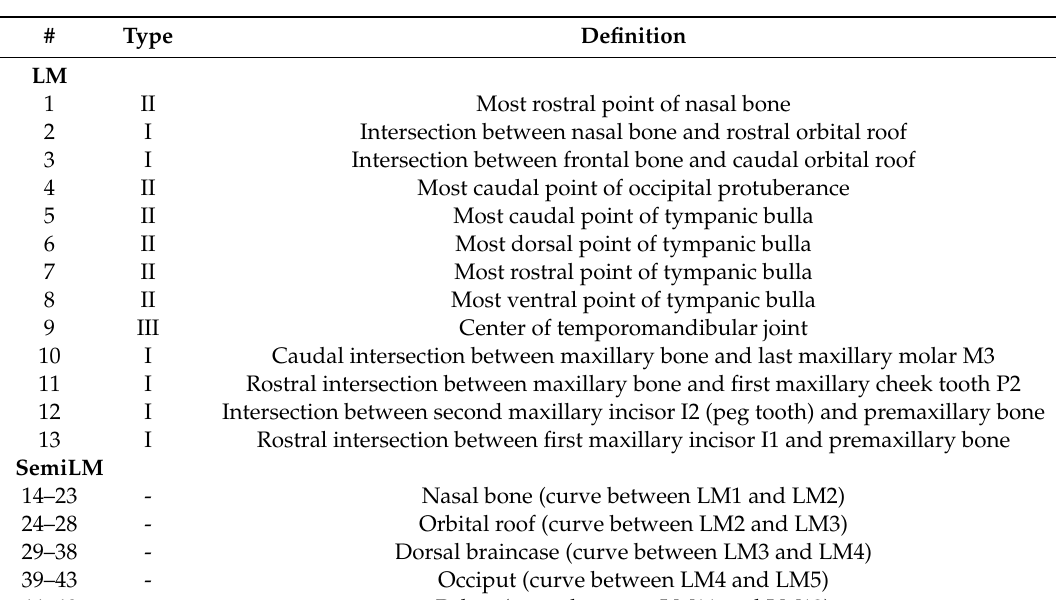
Table 2. Definition of the landmarks (LM) and semilandmarks (semiLM) used in the geometric morphometric analysis. The homologous points were applied to laterolateral X-ray images of the skull. Type I, II, and III landmarks sensu Bookstein [16]. Refer also to Figure